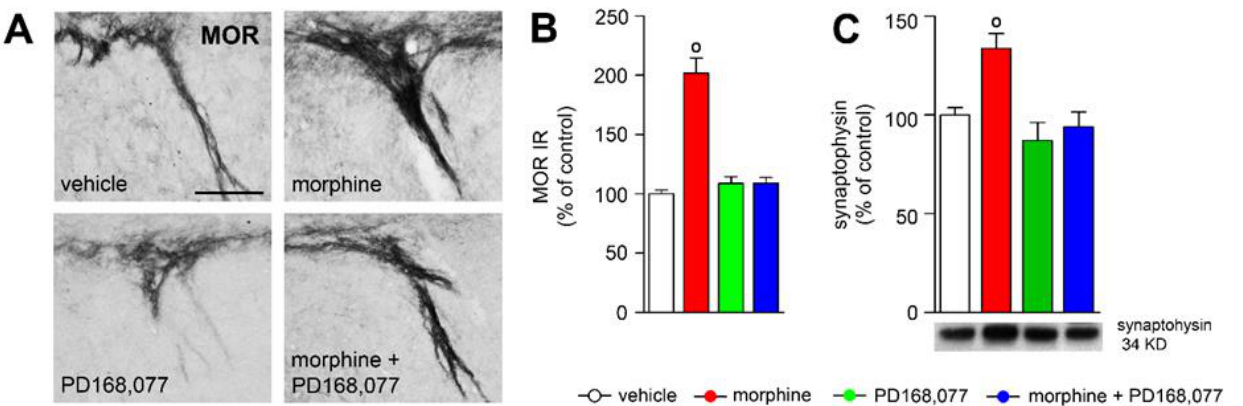
Figure 6. D 4 R agonist treatment counteracts morphine-induced synaptic plasticity in the substantia nigra. ( A ) Representa- tive photomicrographs showing the effect of 7 days of continuous treatment with morphine and/or morphine + PD168,077 on MOR immunoreactivity (IR) in the striosome-dendron bouquets of the sustantia nigra. ( B ) Graph represents the semi- quantitative analyses of MOR IR in the striosome-dendron bouquets of the sustantia nigra. ( C ) Histogram shows synap- tophysin protein levels in the substantia nigra determined by western blotting analysis. Image are representative of four separate western blots. Data represent mean ± SEM, n = 4. ◦ p < 0.05 vehicle vs. morphine; Kruskal-Wallis test followed by Dunn’s method ( B ) or one-way ANOVA followed by Tukey test ( C ). Scale bar is 100 μ